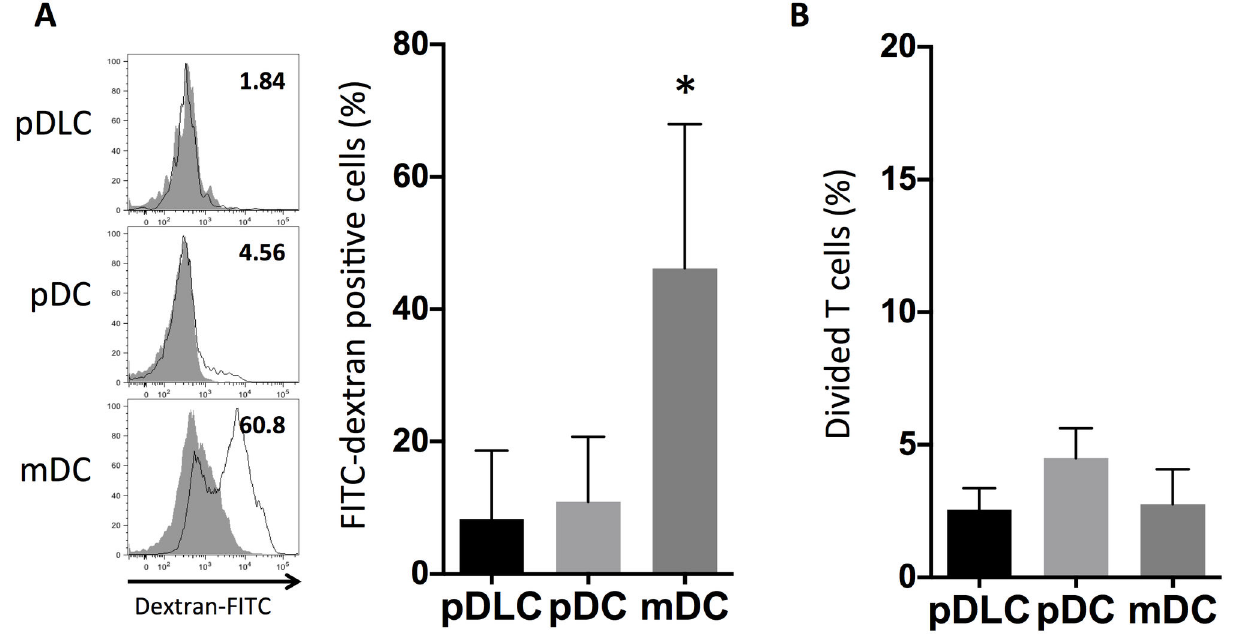
Figure 4. pDLCs exhibit lower endocytic activity than that in mDCs, and also induce less proliferation of CD4 + T cells than that in pDCs. * P < 0.05 compared to pDLC. (A) PBMCs were incubated with FITC–dextran and analyzed by flow cytometry. The open histograms represent 37°C- and the filled histograms represent 4°C-cultured cells. Results of one representative experiment are presented (left). The average frequencies of FITC–dextran positive cells are indicated (n = 5, right). (B) Sorted DCs were co- cultured for 72 h with CFSE-labeled CD4 + T cells under CpG stimulation (1µM). The average frequencies of divided CD4 positive cells are indicated (n =